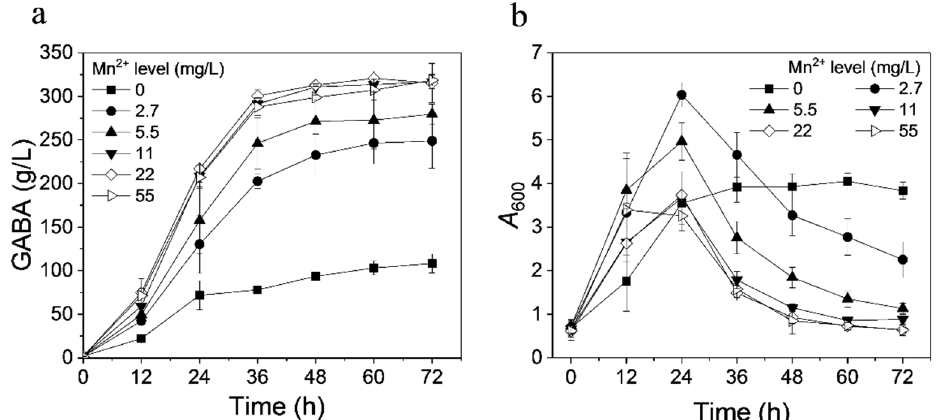
Figure 3. The effect of manganese ion on ( a ) GABA production and ( b ) cell growth. This was evaluated using a 250 mL Erlenmeyer fermentation flask at 32.0 °C. Cell growth was expressed as A 600 . Vertical bars represent standard deviations of means ( n = 3). The difference in 48 h GABA concentrations was not significant between 22 mg/L and 11 ( p = 1.000), 55 ( p = 0.936), or 5.5 mg/L of Mn 2+ ( p = 0.159), but it was significant between 22 mg/L and 2.7 ( p = 0.003) or 0 mg/L of Mn 2+ ( p = 0.000). GABA, gamma-aminobutyric acid; A 600 , absorbance at 600 nm.